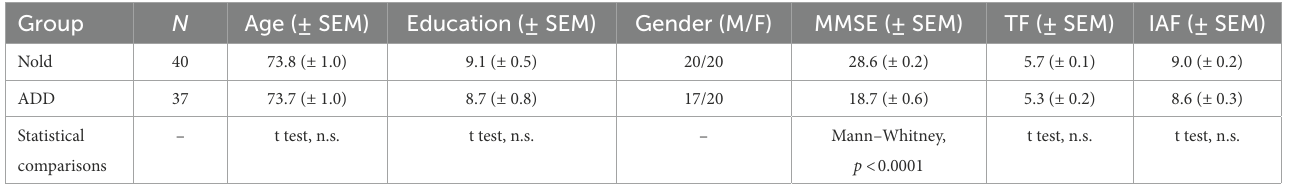
TABLE 1 Demographic, clinical, neuropsychological, and neurophysiological characteristics of the normal elderly (Nold) subject and Alzheimer’s Disease with Dementia (ADD) patients enrolled in the present study. Group